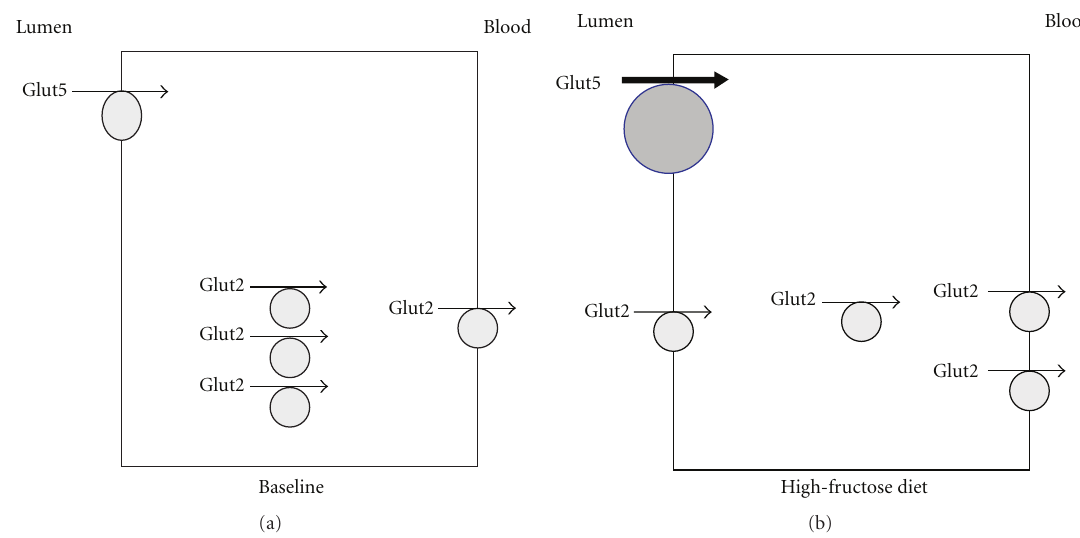
Figure 1: Localization of Glut2 and Glut5 in jejunum and their regulation in response to increased dietary fructose intake. Glut5 which only transports fructose but not glucose resides in the apical membrane at basal state (a) and is activated in response to increased dietary fructose intake (b). Glut2 which can transport both glucose and fructose is expressed in the cytoplasm and on basolateral membrane at basal state (a) and is recruited to the apical membrane in the presence of increased dietary fructose or glucose intake.